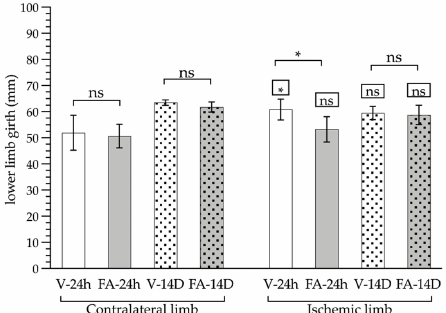
Figure 2. Measurements of the perimeter (in millimeters) of the limb subjected to ischemia (right limb) and the healthy contralateral limb (not subjected to ischemia, left limb), after a period of 24 h (smooth bars) or 14 days (dotted bars) of reperfusion and treatment with folinic acid (FA, gray bars) or saline (V, white bars). The statistical significance levels shown in the squares above the bars show the results of the statistical comparison between the ischemic limbs and the healthy contralateral limbs in the same experimental group (paired analysis). The significance levels shown in the square brackets refer to the comparison between the groups indicated (*: p < 0.05; ns: p > 0.05). The weight of the gastrocnemius muscle of the limb not subjected to ischemia re- mained constant despite treatment and was not modified throughout the days of the ex- Antioxidants 2022 , 11 , x FOR PEER REVIEW periment. In contrast, in the ischemic limb, 24 h after ischemia, the weight of the gas- trocnemius muscle in the untreated animals was increased by 30% compared to the con- tralateral limb (2.84 ± 0.24 vs. 2.18 ± 0.08 g; p < 0.0001). However, in those animals that received FA, this increase was reduced to just 20% (2.46 ± 0.15 vs. 2.06 ± 0.05 g; p < 0.0001). On day 14, while the untreated animals still showed a significant reduction in the gas- trocnemius weight (1.60 ± 0.14 g; p < 0.05), in the FA treated animals, the muscle recovered its normal weight (1.88 ± 1.24 vs. 2.02 ± 0.25 g; p > 0.05) (Figure 3).